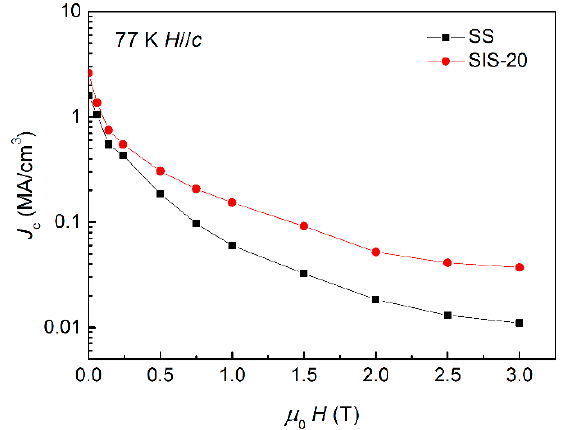
Figure 3. J c versus the magnetic field of samples SS and SIS-20.